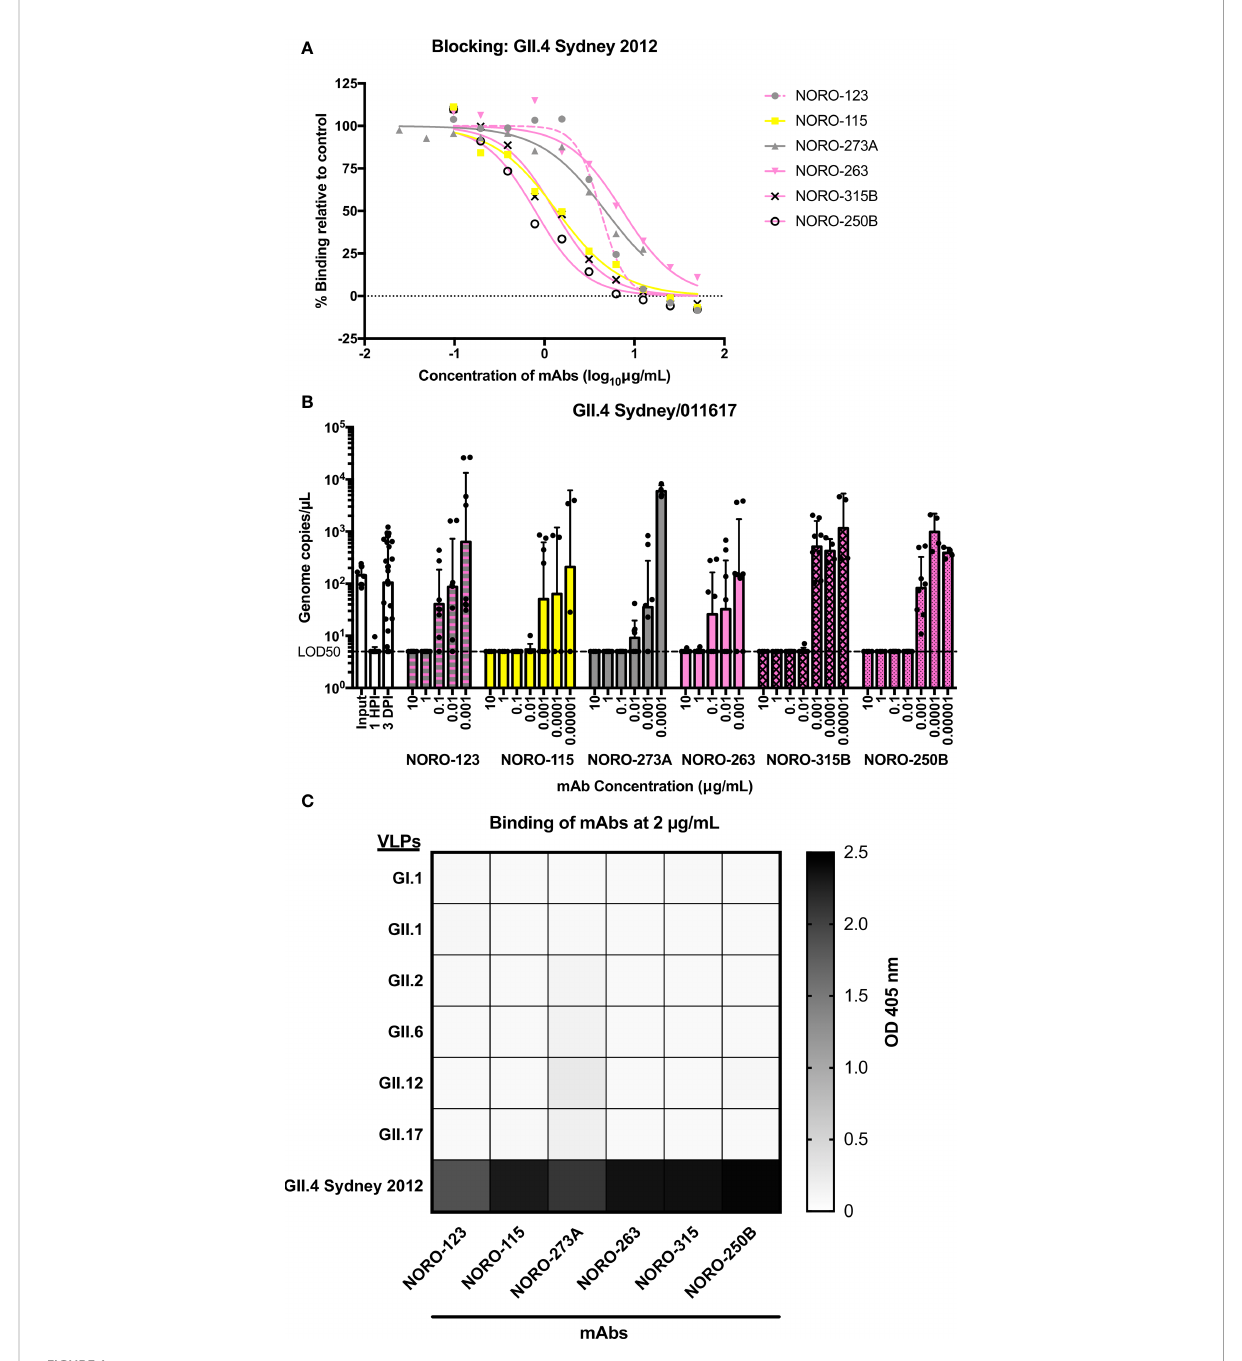
FIGURE 1 Human mAbs isolated from individuals infected with a GII.4 Sydney 2012 variant exhibit blocking and neutralization against GII.4 Sydney 2012, but not against non-GII.4 genotypes. (A) Carbohydrate blocking of human mAbs against a GII.4 Sydney 2012 variant virus (RockvilleD1/2012). Blocking of serial dilutions of mAbs (starting at 50 m g/mL or 12.5 m g/mL) was determined by comparing the signal to that of the positive control, binding of VLPs in the absence of mAbs. (B) Neutralization of a GII.4 Sydney 2012 virus (strain 011617) with different concentrations of human mAbs. The dashed line represents 5 genome copies/µL, which is the copy number per µL for which the limit of detection is 50% (LOD 50 ) or the “ neutralization threshold ” , which was de fi ned as the average of genome copies/µL after 1 hour post-inoculation (HPI) such that samples presenting values below the line were unable to replicate and were therefore neutralized. All virus inoculations were performed in the presence of 0.5 mM glycochenodeoxycholic acid (GCDCA), a glycine-conjugated form of the primary bile acid chenodeoxycholic acid. The graph represents the average values of two independent experiments. The error bars represent the geometric standard deviation of the mean. (C) Heat map of the binding of mAbs (at 2 m g/mL) to VLPs of selected genotypes. The value in each cell is the average of the optical density at 405 nm (OD 405 nm) in duplicate